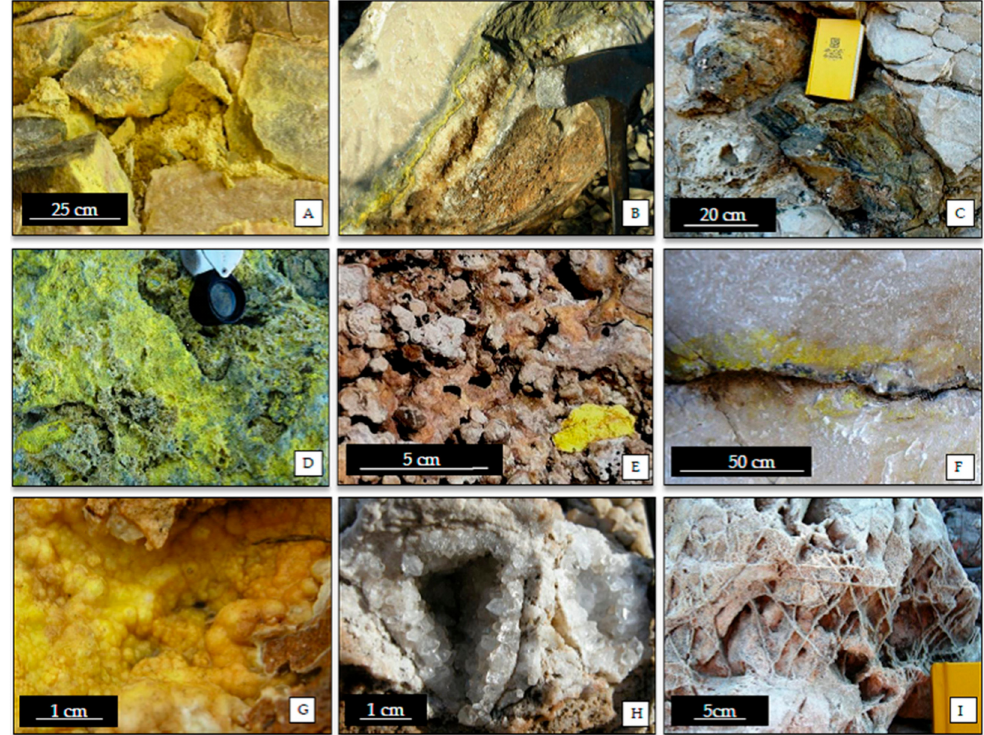
Figure 4. Outcrop photos of U-V mineral occurrences and boxwork the MT/WY deposits: ( A ) Silt-size and powdery coatings, Pryor Mountain U-V Mining District (PMD); ( B ) Boulder with U-V minerals lining fractures filled with calcite, LMD; ( C ) Fracture hosted tectonic hydrothermal breccia (THB) with boxwork formed in host limestone, LMD ( D ) Calcite cemented surface coatings, LMD; ( E ) Cave floor type occurrence, PMD; ( F ) U-V minerals along sprung stylolites, PMD. ( G ) Silica and U minerals coating breccia clasts, PMD; ( H ) Quartz-lined boxwork, PMD; and ( I ) Systematic fractures preserved as boxwork, LMD. Figure modified from Moore-Nall and Lageson